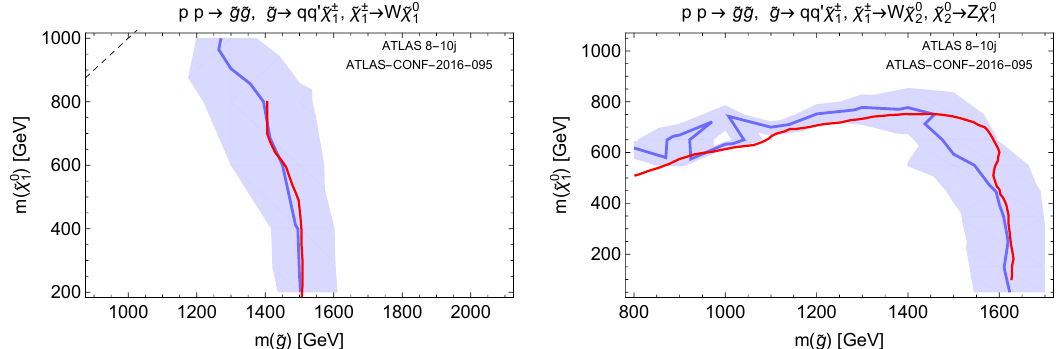
Figure 14 . Limits on supersymmetric simpli(cid:12)ed models from our recasted search of [49] (blue line) with 50% error on the number of events in the signal regions (blue shaded region), compared to the experimental results (red